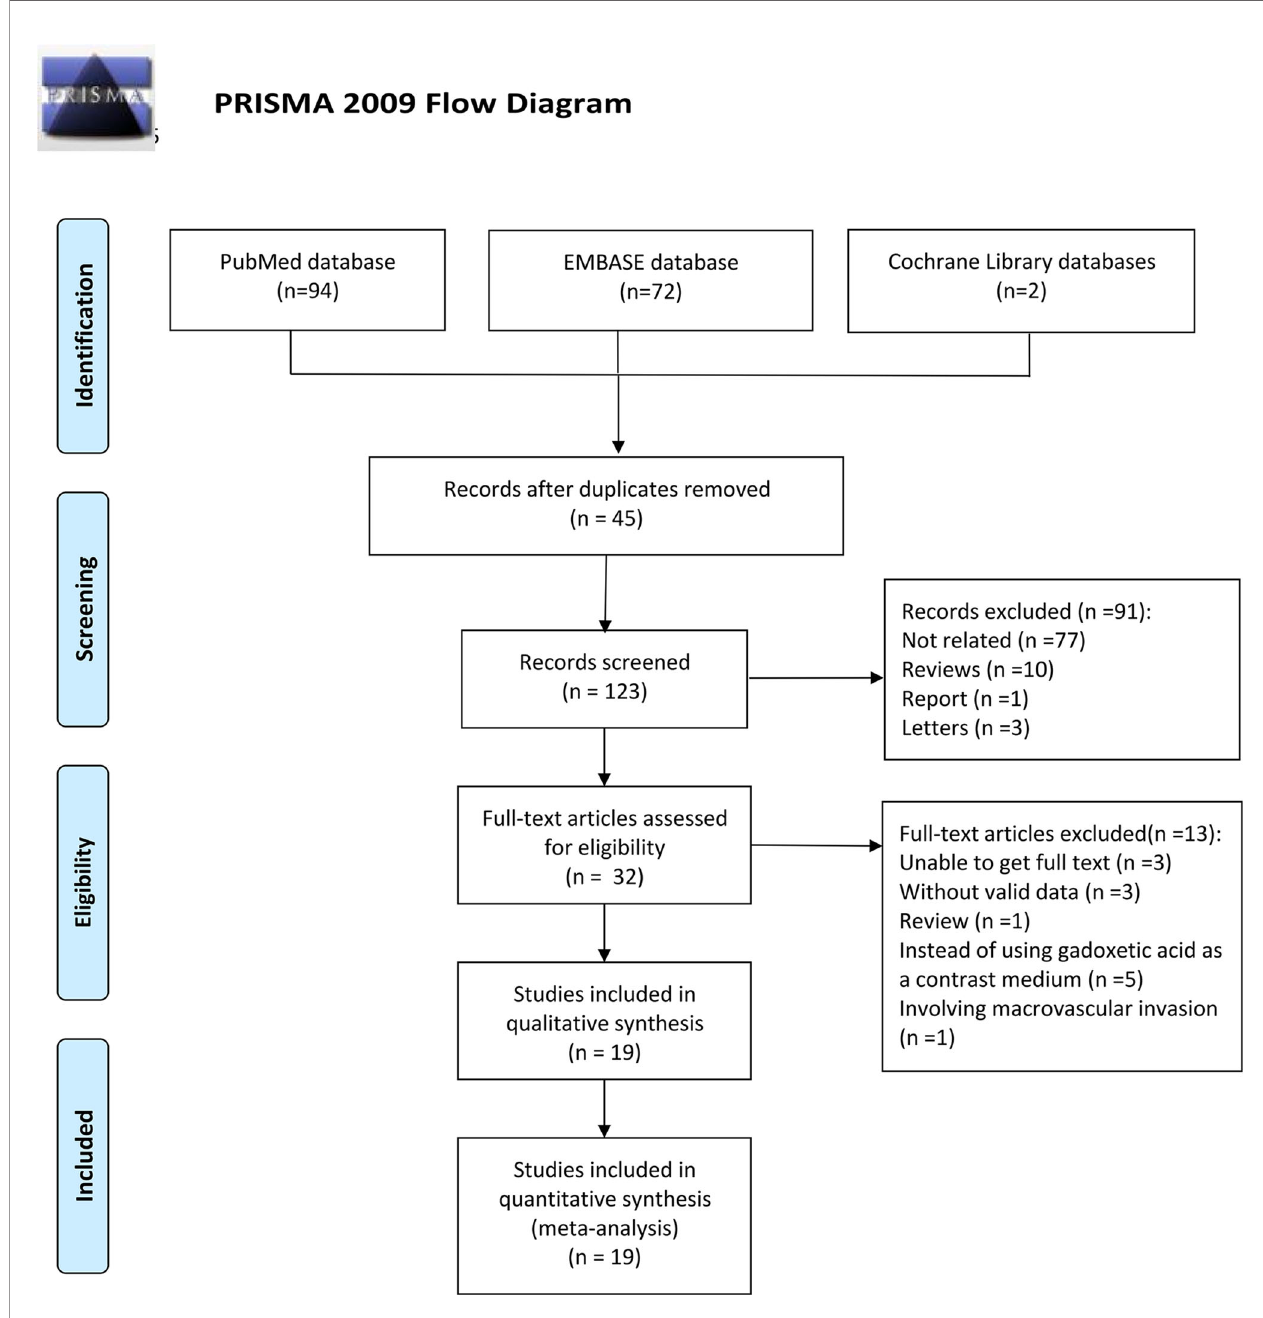
FIGURE 1 | Flow diagram illustrating the search